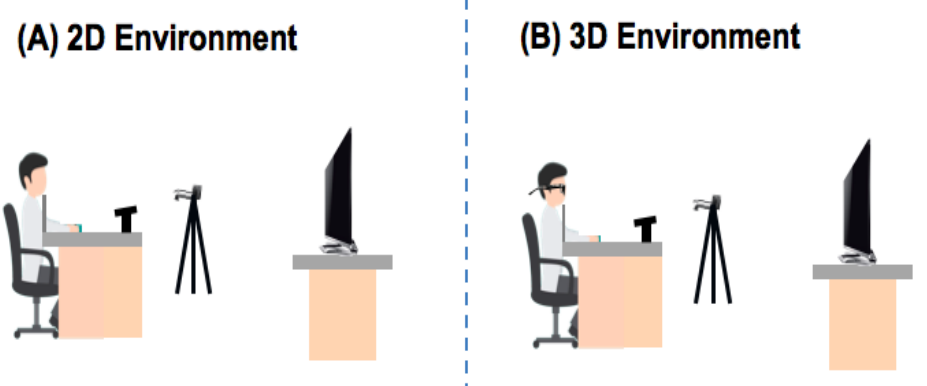
Figure 2. The illustration of two different environments. ( A ) Participant performed tapping task in a 2D environment. ( B ) Participant utilized 3D glasses to perform the multi-directional tapping task in a 3D environment. 3D TVs were integrated with NVIDIA to create a stereoscopic viewing envi- ronment.